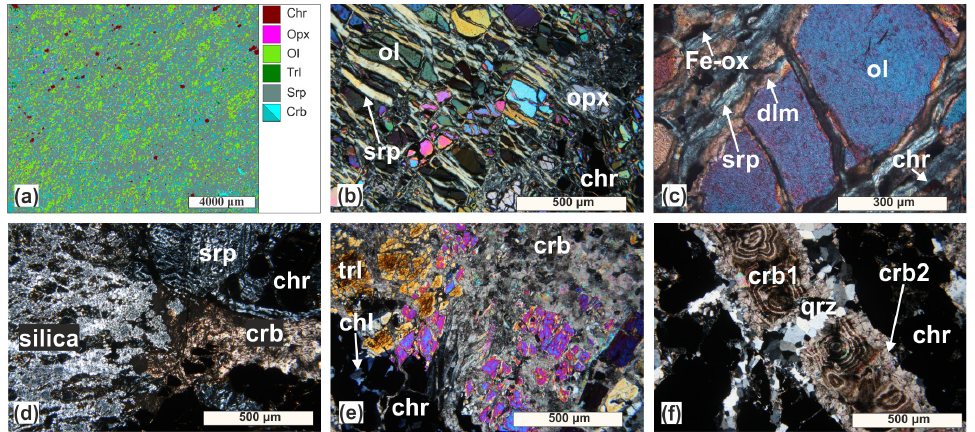
Figure 4. ( a ) QEMSCAN false-color image illustrating altered cataclastic dunite with olivine being fragmented into ~86 µm particles; photomicrographs of: ( b ) coarse grained cataclastic dunite composed of olivine (up to 500 µm) that is altered into serpentine; ( c ) fractured olivine grained altered into dolomite, serpentine and Fe-oxides; ( d ) listwaenitized chromitite composed of silica mass and relict serpentine patches, carbonate veins and chromite; ( e ) listwaenitized chromitite consisting of acicular tremolite and granoblastic carbonates and relict chromite with chlorite corona; ( f ) vein consisting of two carbonate phases, namely nodular and layered, predating quartz’s deposition. Abbreviations: chr = chromite; opx = orthopyroxene; ol = olivine; trl = tremolite; srp = serpentine; crb = carbonate minerals; dlm = dolomite; Fe-ox = Fe-oxides; chl = chlorite; qrz = quartz; crb1 and crb2 two petrographically distinct carbonate phases.